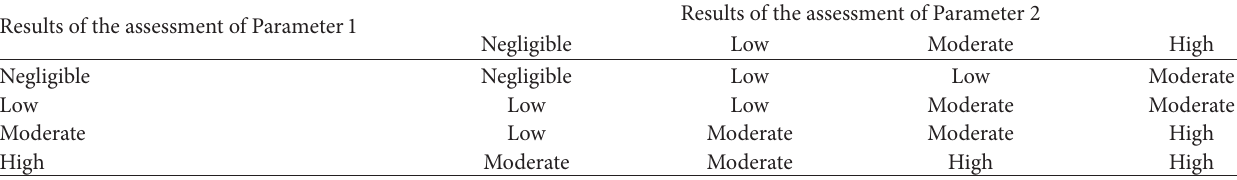
Figure 4: Scenario tree for consequence assessment. Table 2: Matrix showing probabilities when two parameters are combined